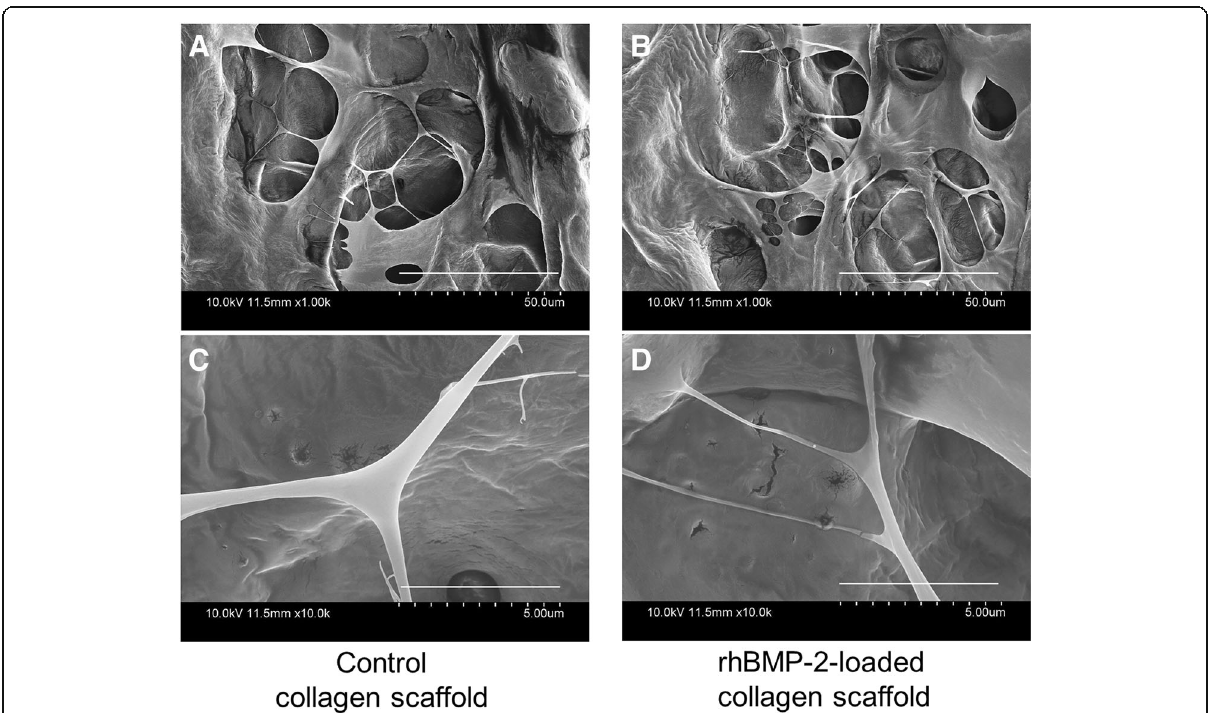
Fig. 2 SEM images of the collagen scaffold (control, left panel, a , c ) and BMP-2-loaded collagen scaffold (right panel, b , d ). Images are taken at ×1000 ( a , b ) and ×10,000 magnification ( c , d